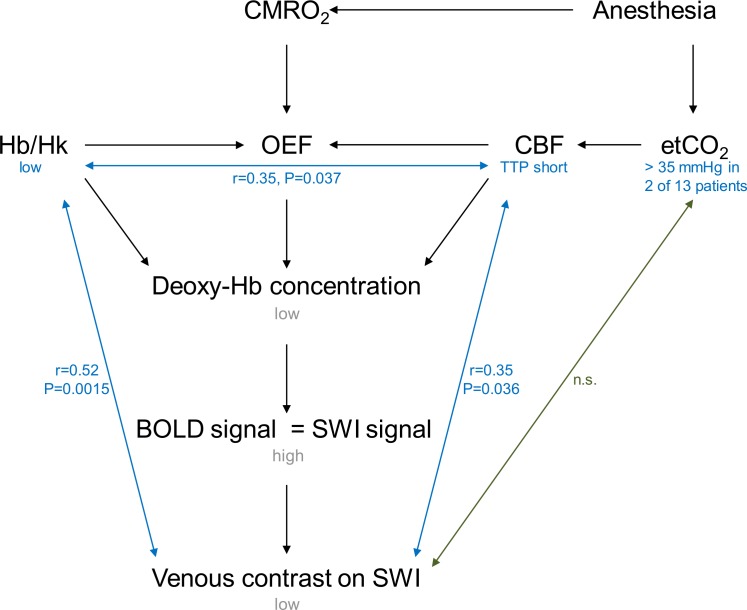
Schematic depicting factors which may influence the venous contrast on SWI.Note: CMRO2 = cerebral metabolic rate of oxygen, Hb = hemoglobin, Hk = hematocrit, OEF = oxygen extraction fraction, CBF = cerebral blood flow, TTP = time-to-peak, etCO2 = end-tidal CO2, BOLD = blood oxygen level dependent, SWI = susceptibility-weighted imaging, n.s. = not significant.